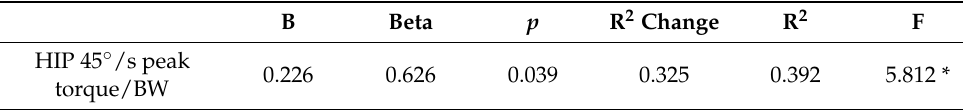
Table 4. Stepwise regression analysis for prediction of HR peak